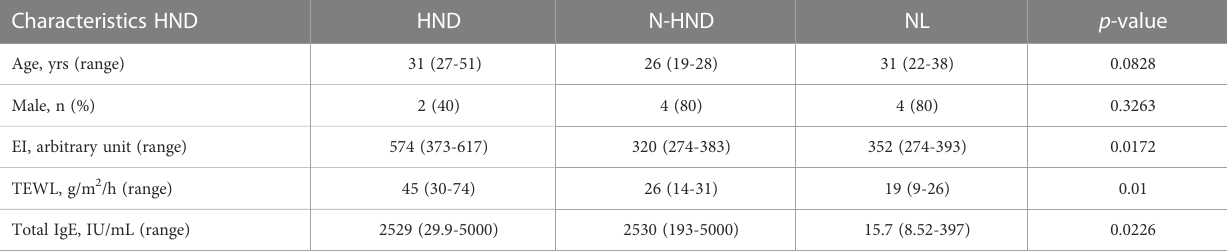
TABLE 2 Basal characteristics, EI, TEWL, and total serum IgE of study